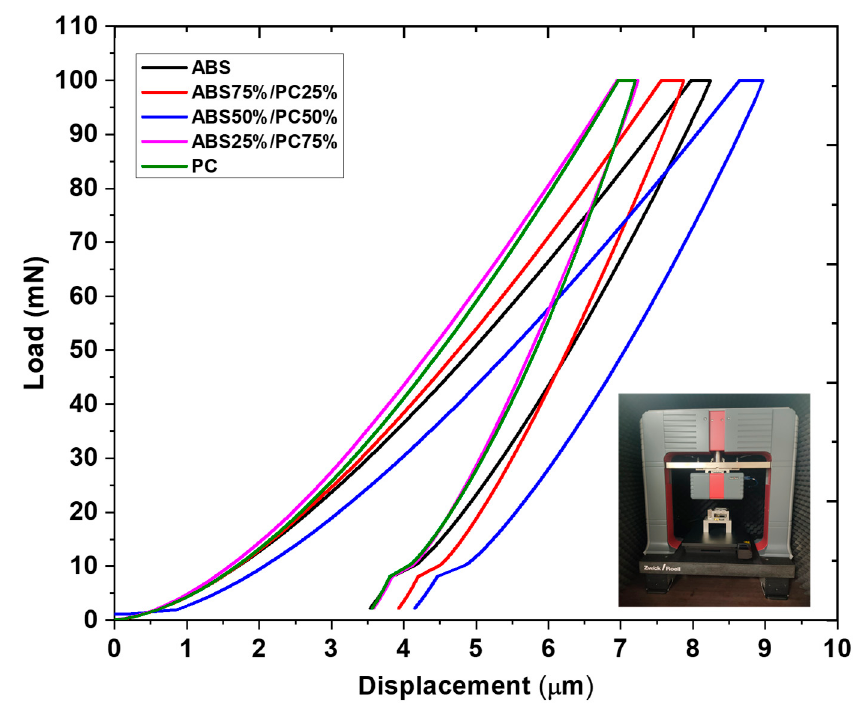
Figure 3. Load ‐ displacement curves for five different samples of ABS, PC, and ABS/PC blends. Figure 3. Load-displacement curves for five different samples of ABS, PC, and ABS/PC blends.